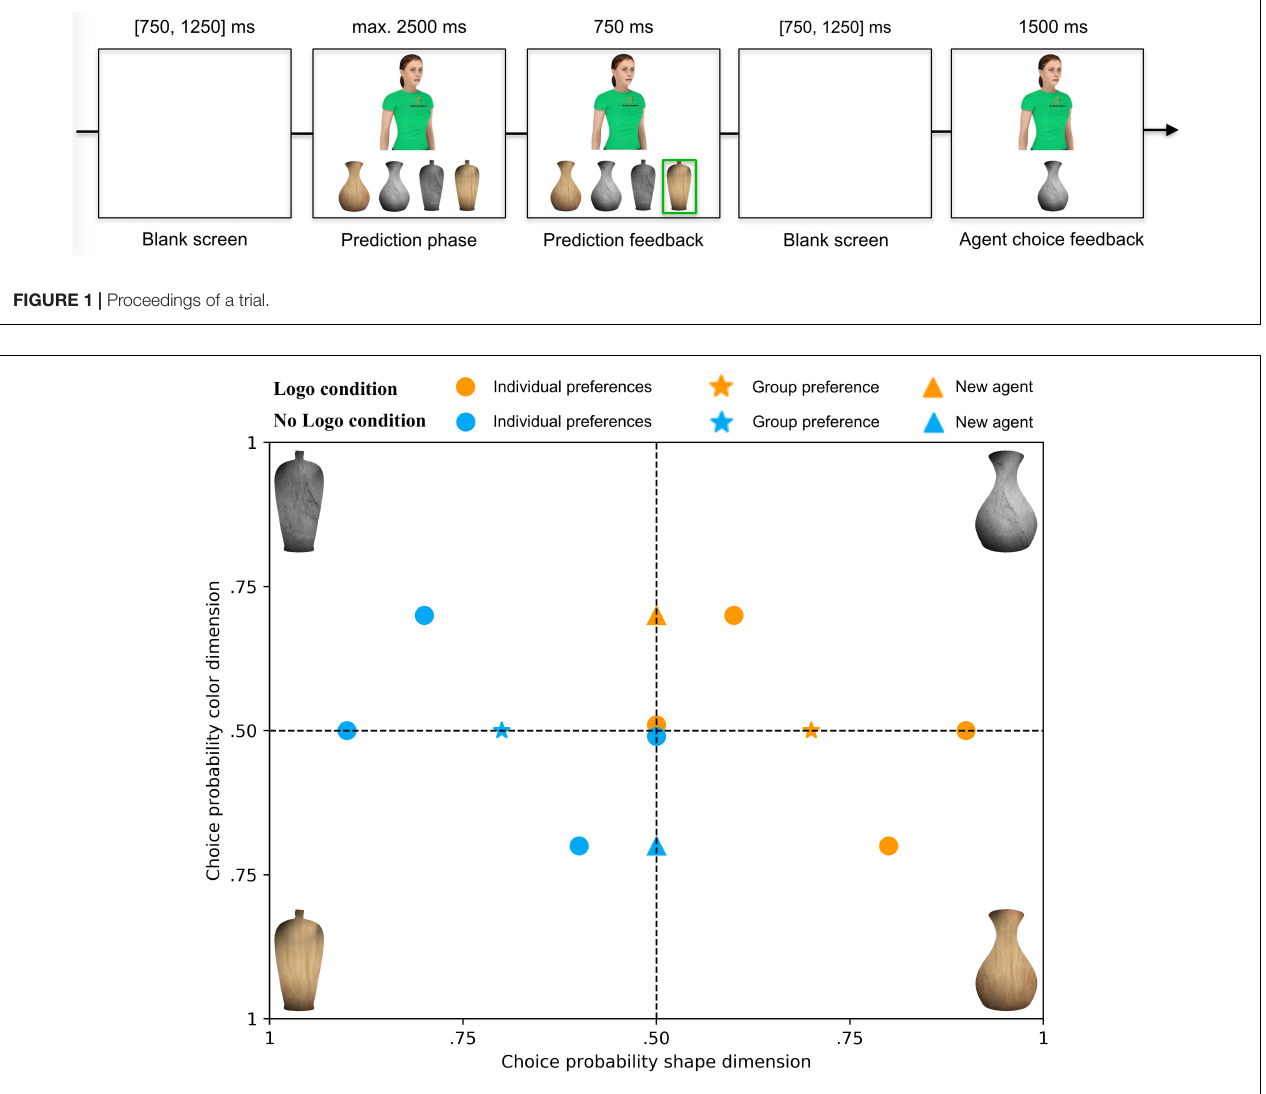
FIGURE 2 | Experimentally manipulated individual-level and group-level preferences. Presented are the experimentally defined individual agent preference distributions (filled circles) belonging to the Logo and No Logo condition (orange and blue, respectively). The group-level preference distributions are depicted by the asterisks, which is the average of all individual preference distributions in that condition. The newly introduced agents in Block 2 are depicted by triangles. Vases varied on the shape and color dimensions. The x-axis reflects the probability of choosing a certain color and the y-axis a certain shape, resulting in preferences for the four choice